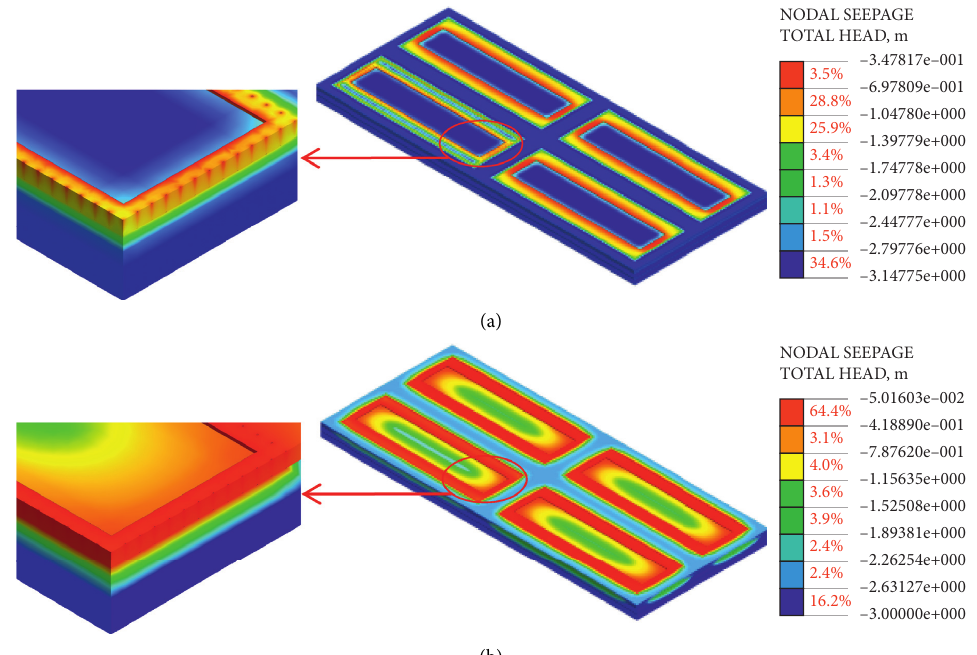
Figure 23: Total head nephograms of buildings with seepage wells placed around building 1 following (a) 10min and (b) 120min of rainfall in the numerical model (the color of the legend represents the total head range. The value of the legend represents the total head value. The red % represents the volume percentage of color legend in the whole numerical model.).